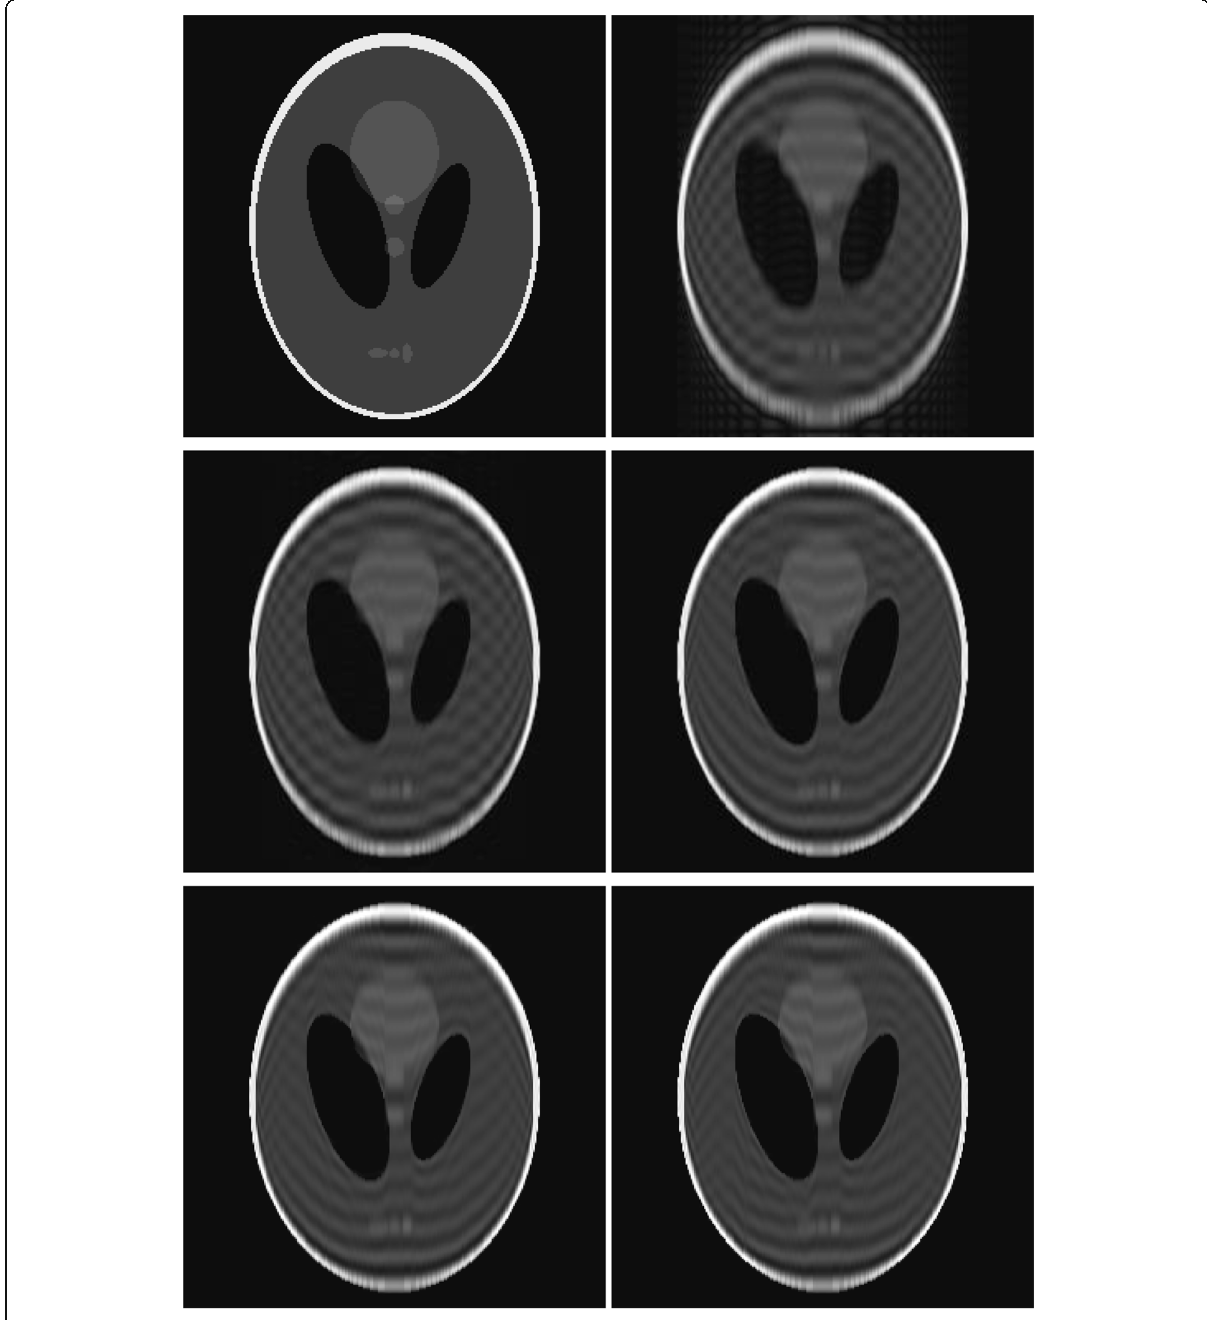
Fig. 3 Reconstruction of the Shepp-Logan phantom with noiseless data. Row 1: (L) the true phantom; (R) the result with the initial condition. Row 2: (L) the result with 10 2 iterations; (R) the result with 10 4 iterations. Row 3: (L) the result with 10 6 iterations; (R) the result with 10 8